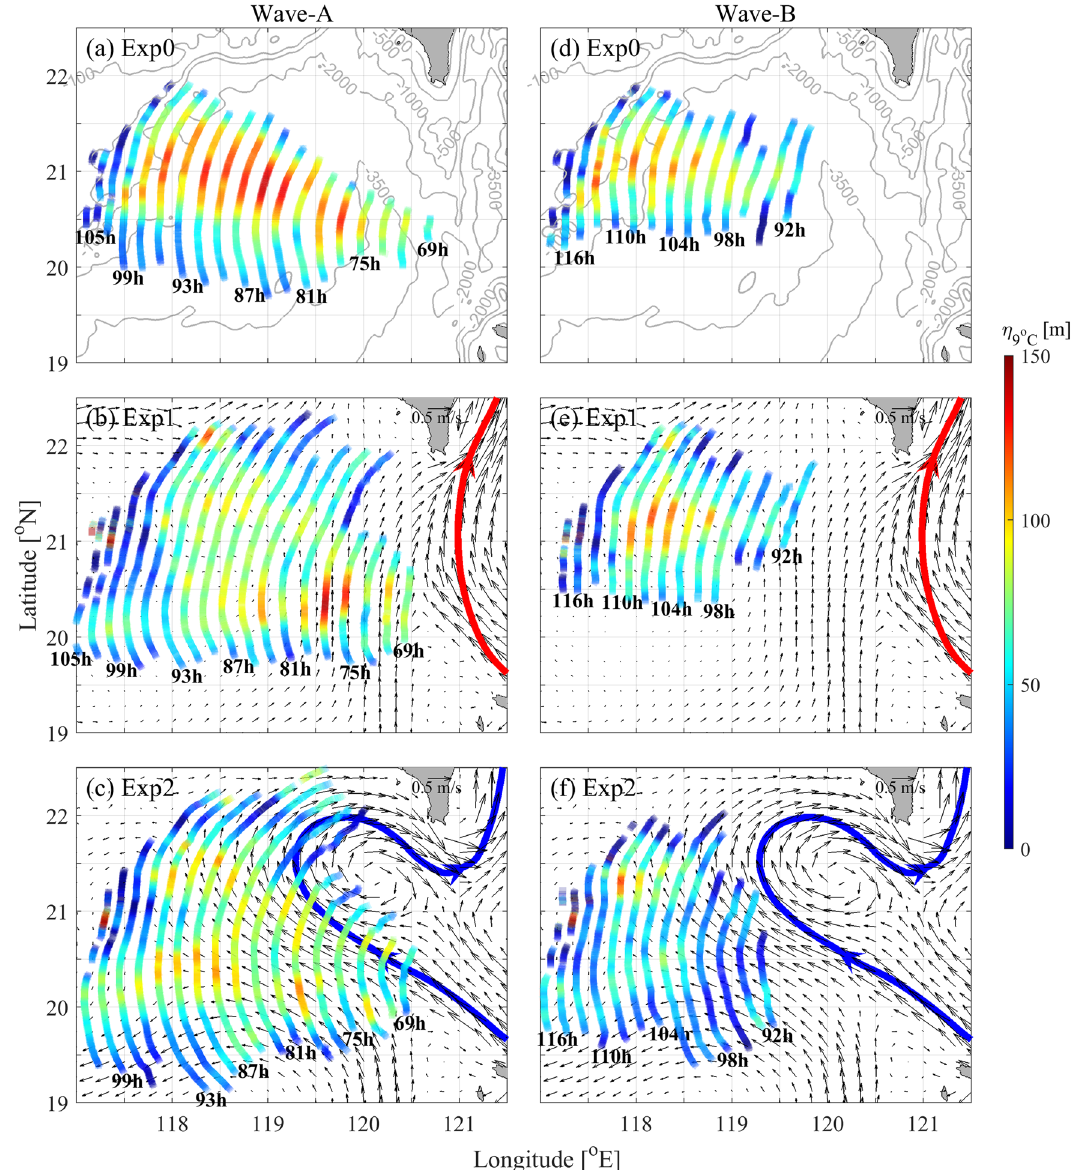
Figure 7. Wave amplitudes (shadings, units: m) along the crest lines for the A-wave and B-wave in Exp0 ( a,d ), Exp1 ( b,e ) and Exp2 ( c,f ). Contours in ( a,d ) denote the bathymetry. Surface background currents are indicated by black arrows in ( b,c,e,f ). The leaping and looping paths of the Kuroshio are marked by red and blue curves, Exp1, for the A-wave, the energy is lower and divergent in comparison to Exp0 (Fig. 8b). The B-wave basically shares a similar pattern to that in Exp0, with a bit smaller energy but longer crest lines. In Exp2, the wave energy is further weakened (Fig. 8c,f), because the westward energy flux into the SCS is the weakest among the three runs (Fig. 8i). However, both the A-wave and B-wave have much longer crest lines than those in Exp0 and Exp1. Figure 9 shows the meridional distribution of wave energy. In Exp0, there is a significant peak in the energy of the A-wave, which gradually shifts northward as the A-wave propagates westward across the SCS basin (Fig. 9a–d). Similar feature is also found for the B-wave, although its energy is lower than that of the A-wave (Fig. 9e–h). Under the influence of the Kuroshio, the crest lines of both the A-waves and B-waves are stretched. In Exp1, the maximal value of the A-wave energy is located at 20.4° N in each running time of 69–89 h (Fig. 9a–c, 118.3–120.3° E in Fig. 8b). Double peaks of wave energy appear as the A-wave further propagates into the SCS basin. In contrast, the meridional distribution of the B-wave energy seems to be less influenced by the Kuroshio, since the multi-peak pattern is only found as the wave approaches the continental slope (118.0° E). With the looping Kuroshio, the A-wave energy shows double peaks of energy even near the LS (Fig. 9a,b). Similarly, the B-wave energy also has double peaks, although one peak is lower than the other.